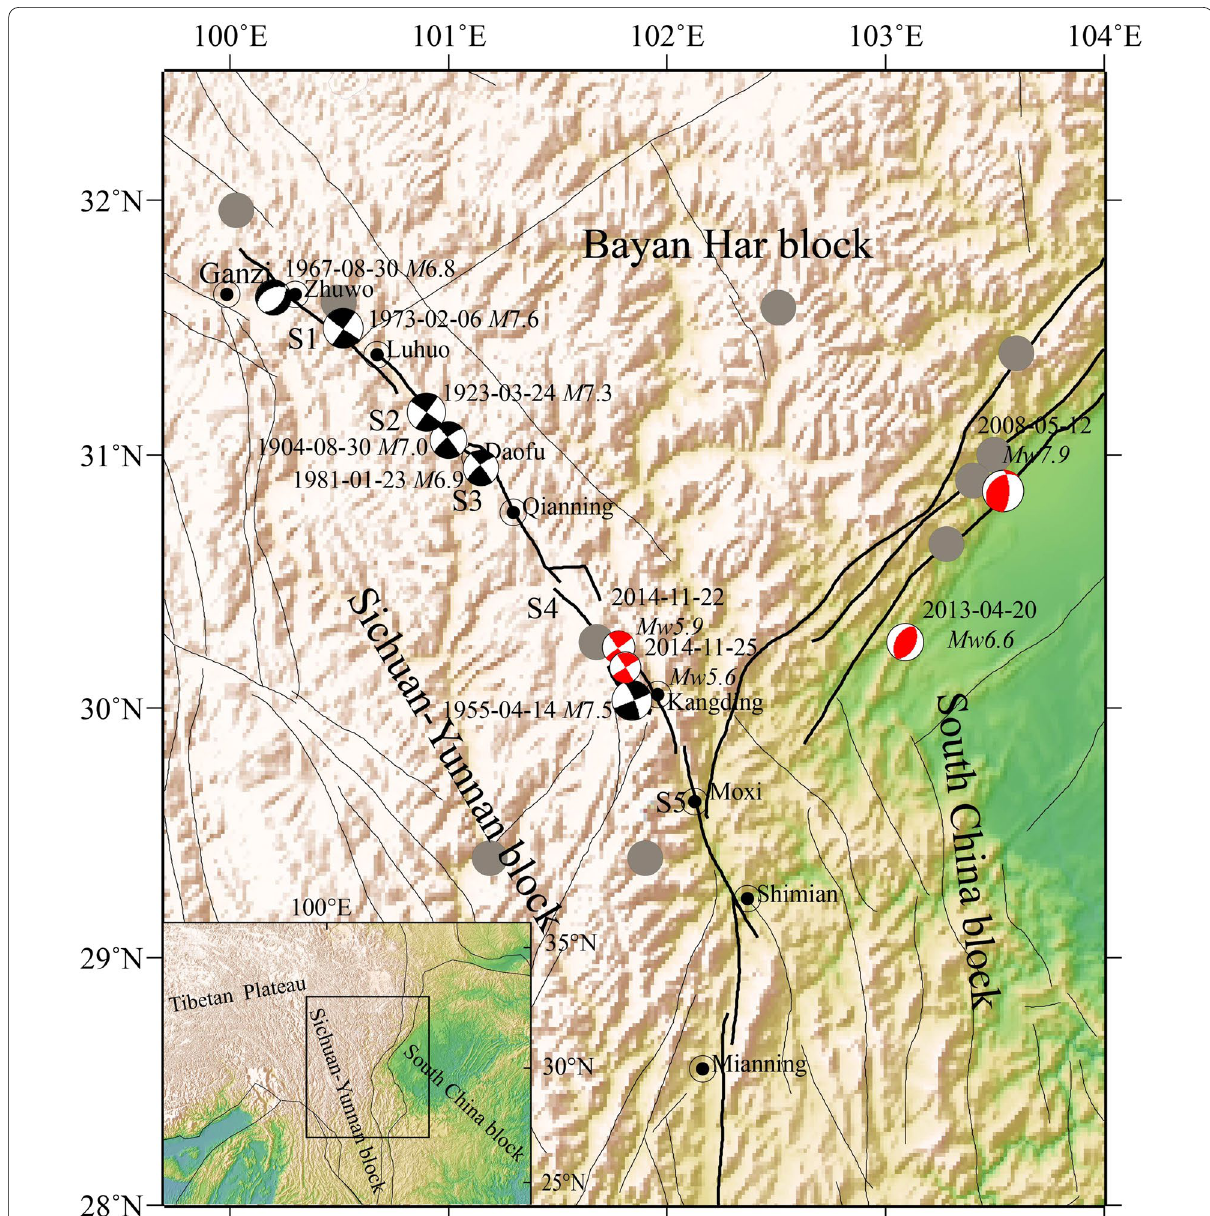
Fig. 1 Tectonic setting and historic seismicity in the eastern Tibetan Plateau. S1–S5 represent the Luhuo, Daofu, Qianning, Kangding, and Moxi sections, respectively. The gray circles represent M 6.5 earthquakes since 1970, and the black beach balls represent the focal mechanisms of the ≥ M 6.7 strong earthquakes from 1900 to 2000 (data source: Xu et al. (2013)). The red beach balls represent the typical earthquakes occurred in the ≥ study area since